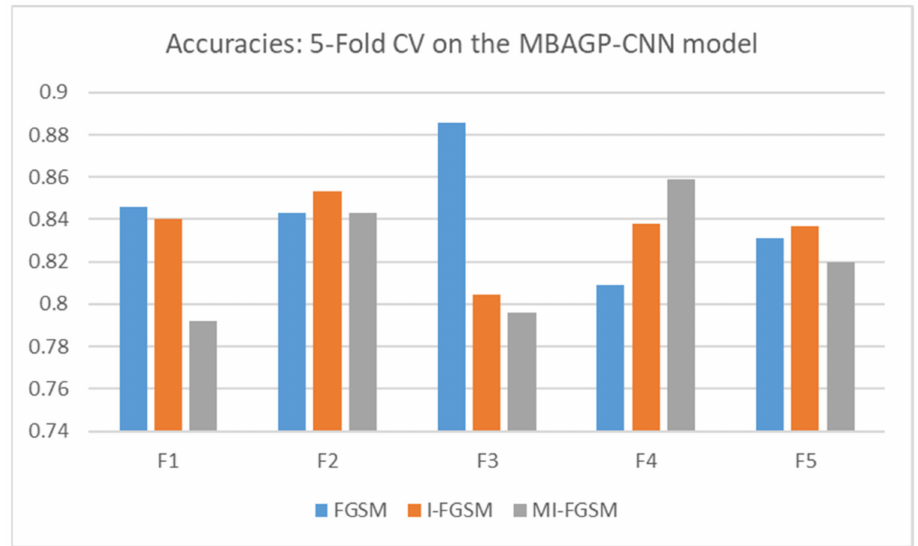
Figure 23. The accuracies achieved by the folds after performing five-fold cross-validation on the MBAGP-CNN solver model based on the FGSM, I-FGSM, and MI-FGSM attacks. The implications of this current study